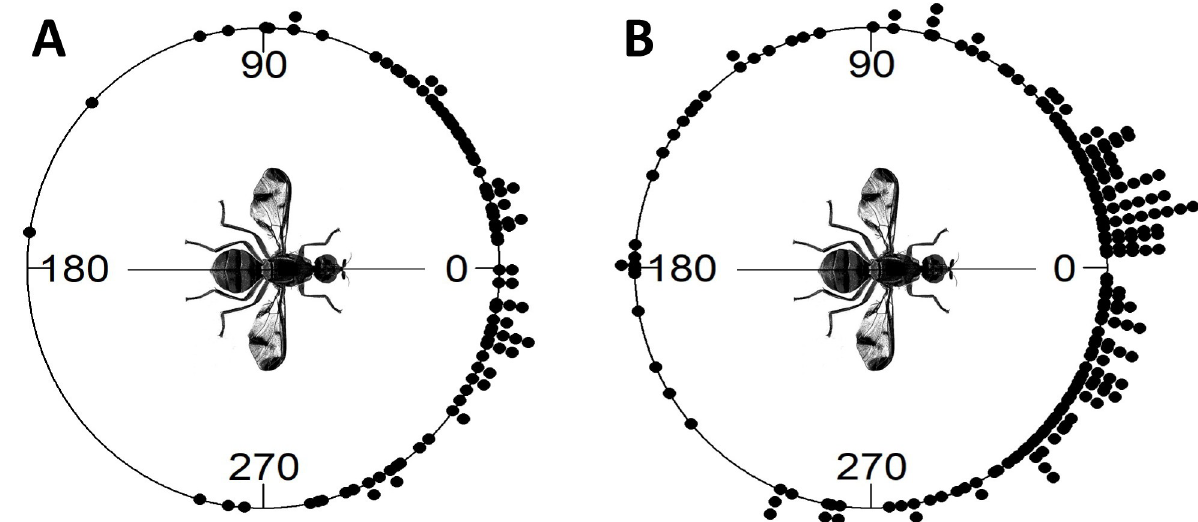
Fig 3. Combined pseudo-turning angles of HR tagged Zeugodacus cucurbitae for experiment 2 (A) and experiment 3 (B). A turning angle of zero indicated that a fly flew in the same direction as the directly previous flight. Combined turning angles were non-random by both Rayleigh and Hermans-Rasson tests, showed no right-left bias, but indicate a pronounced bias towards moving within 90˚ left or right of the directly previous flight.